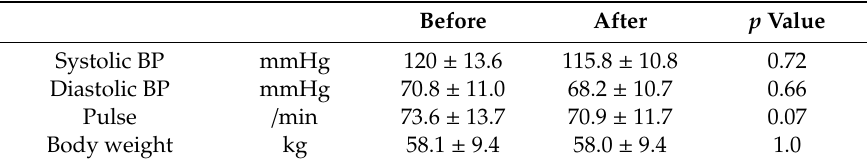
Table 2. Changes in blood pressure (BP), pulse, and body weight.